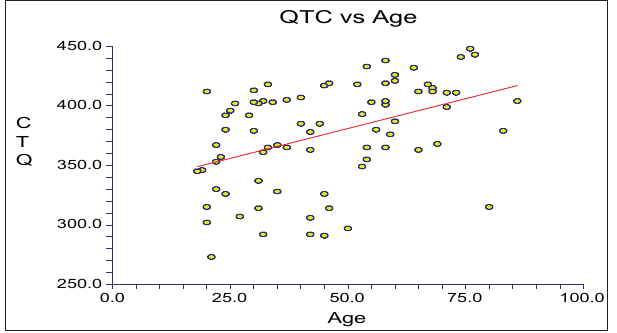
Fig. 1a. Correlation between corrected QT interval and age.